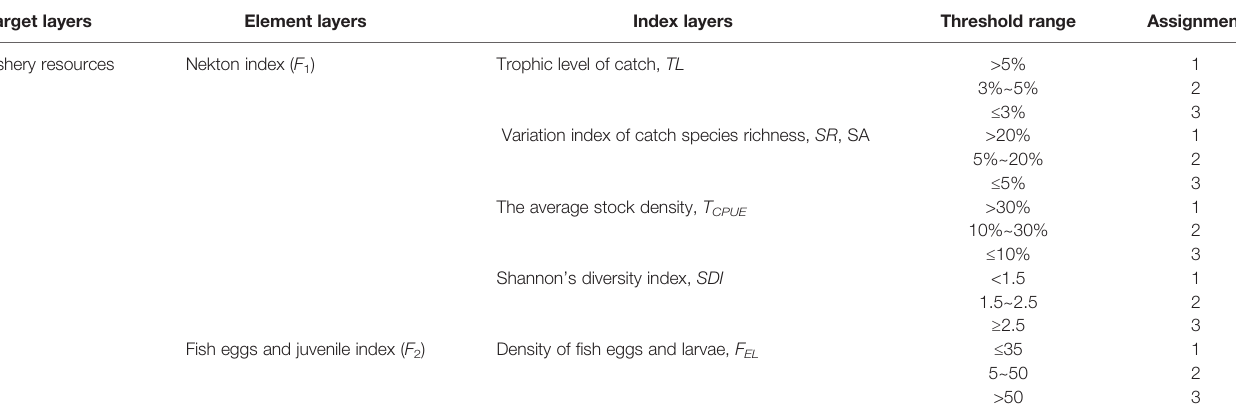
TABLE 2 | Evaluation system of the FRCC.